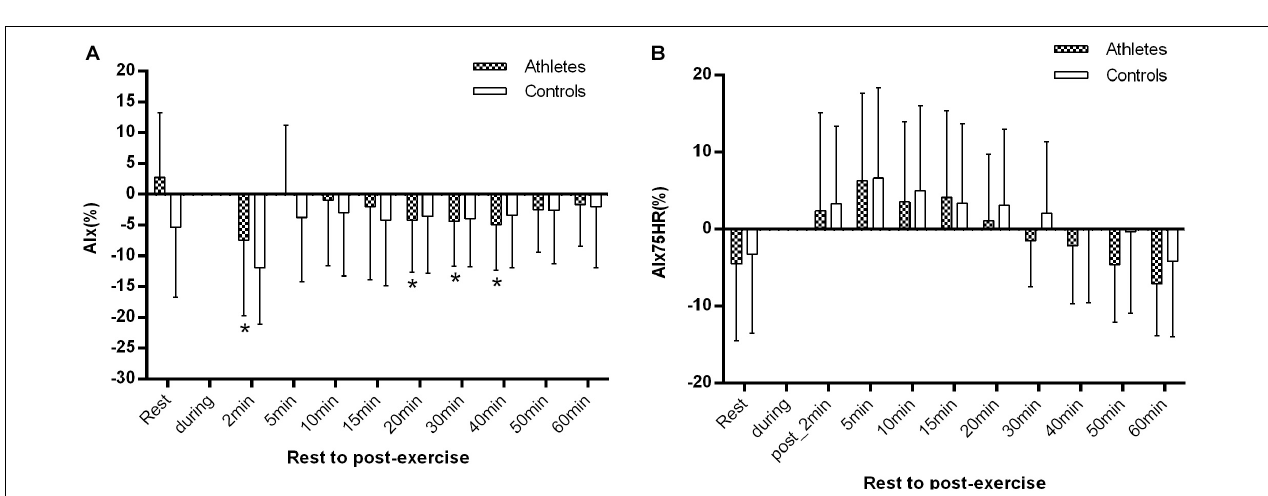
FIGURE 5 | The difference of AIx (A) and AIx@HR75 (B) between athletes and controls before and after exercise. The error bars represent the between-participant standard deviation ( SD ). The “ a ” indicates significant difference between the two groups with p < 0.05; The “*” and “ + ” indicate significant difference between pre- and post-exercise with p < 0.05 in athletes and controls,